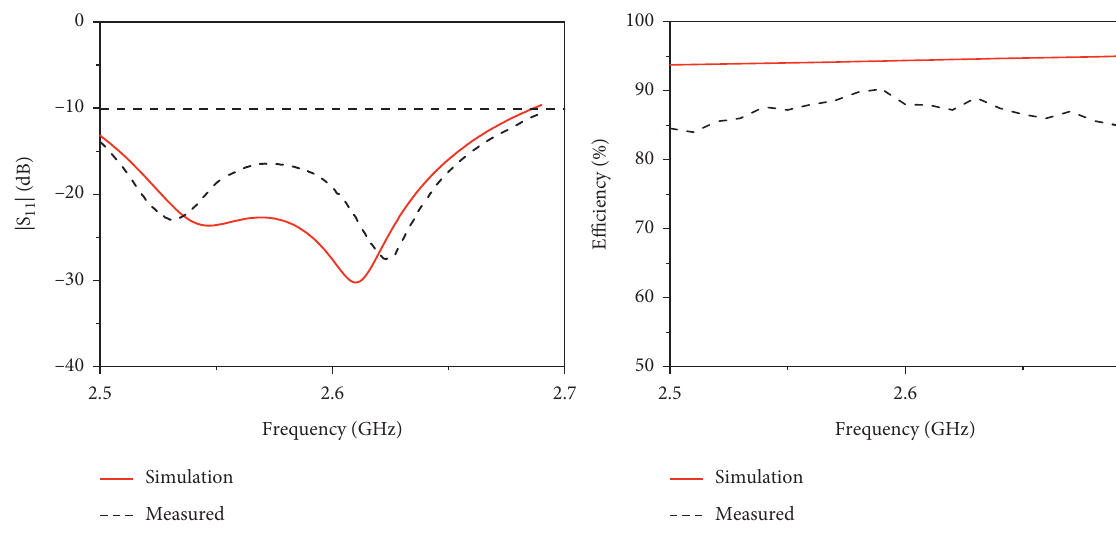
Figure 9: Measured and simulated |S 11 | and efficiency of the reconfigurable antenna